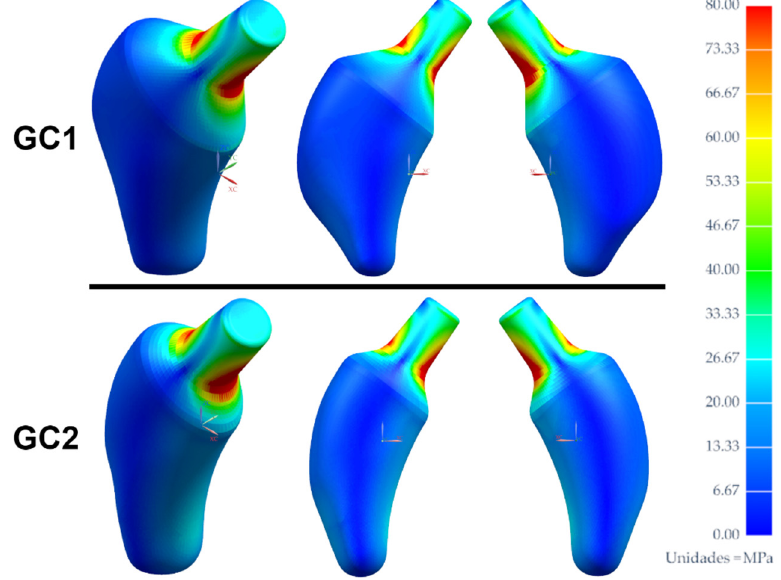
Figure 21. Von Mises stress map of the V3 stem.